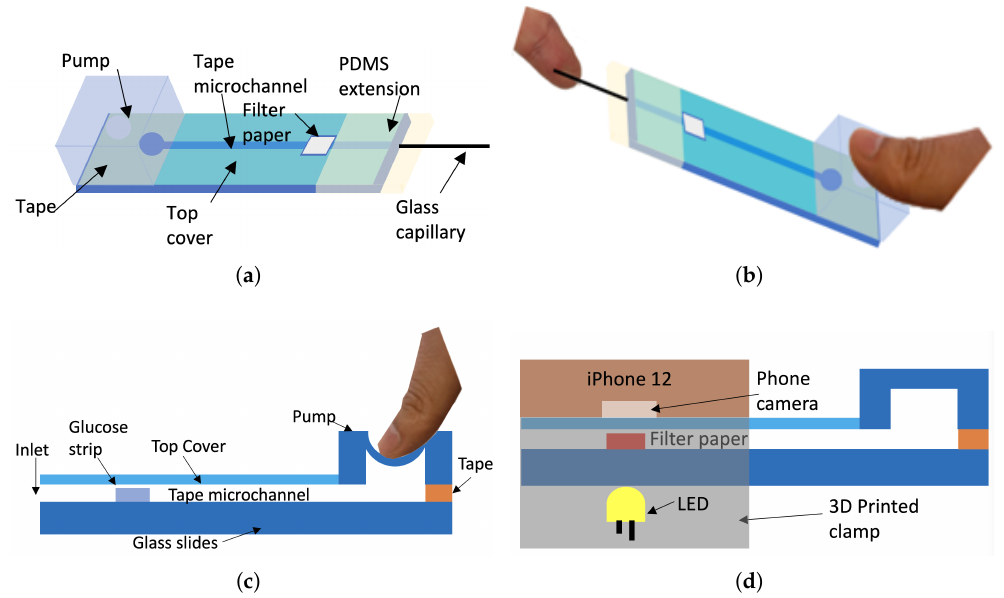
Figure 1. Conceptual pictures of the principle: ( a ) The microfluidic device; ( b ) Dip the microfluidic device in a finger; ( c ) Apply pressure down the micropump to create a negative pressure environment; ( d ) Device in 3D printed phone clamp after